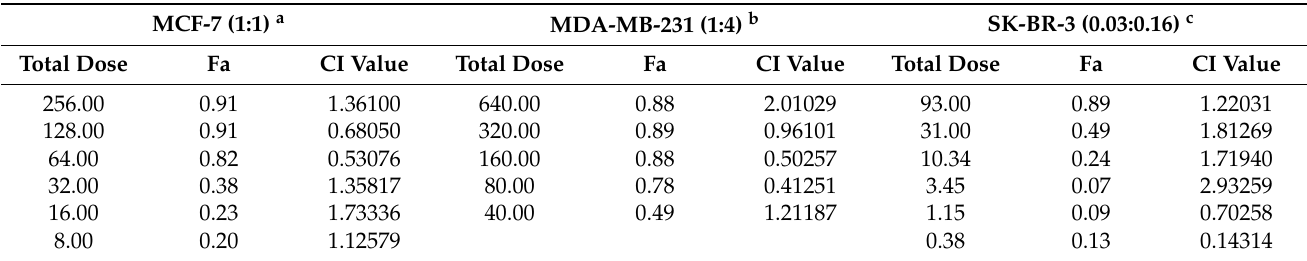
Table 8. Fa and CI values for actual experimental points of gefitinib combined with irinotecan.